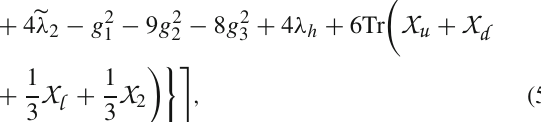
Fig. 3 Running of gauge coupling g 1 with the energy scale μ for dif- ferent leptoquark models at one-loop and two-loop order. The green curve represents SM; the red and yellow ones signify extension of SM with one and three generations of (cid:2) R 2 , respectively; addition of one and three generations of S 3 to SM are indicated by the blue and cyan